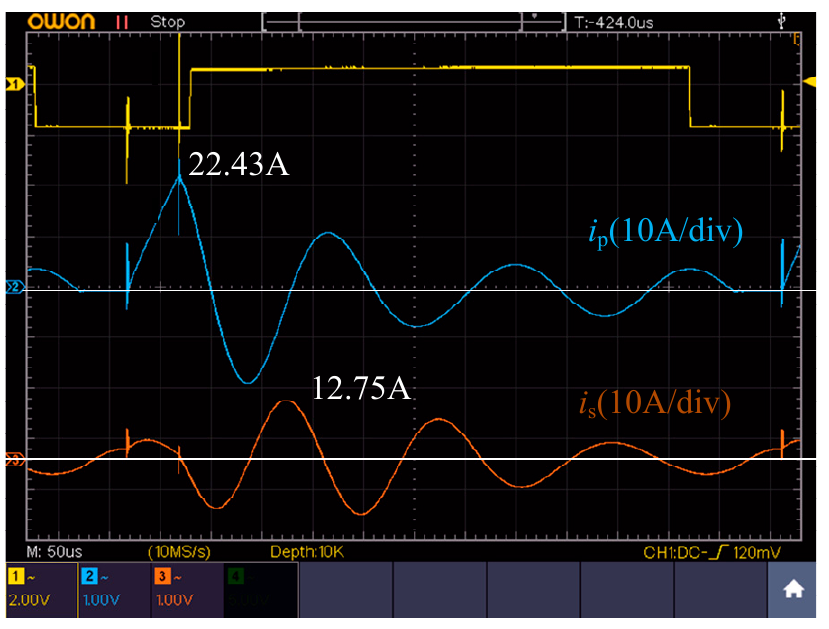
Figure 13. the waveforms of primary current (blue) secondary current (orange).